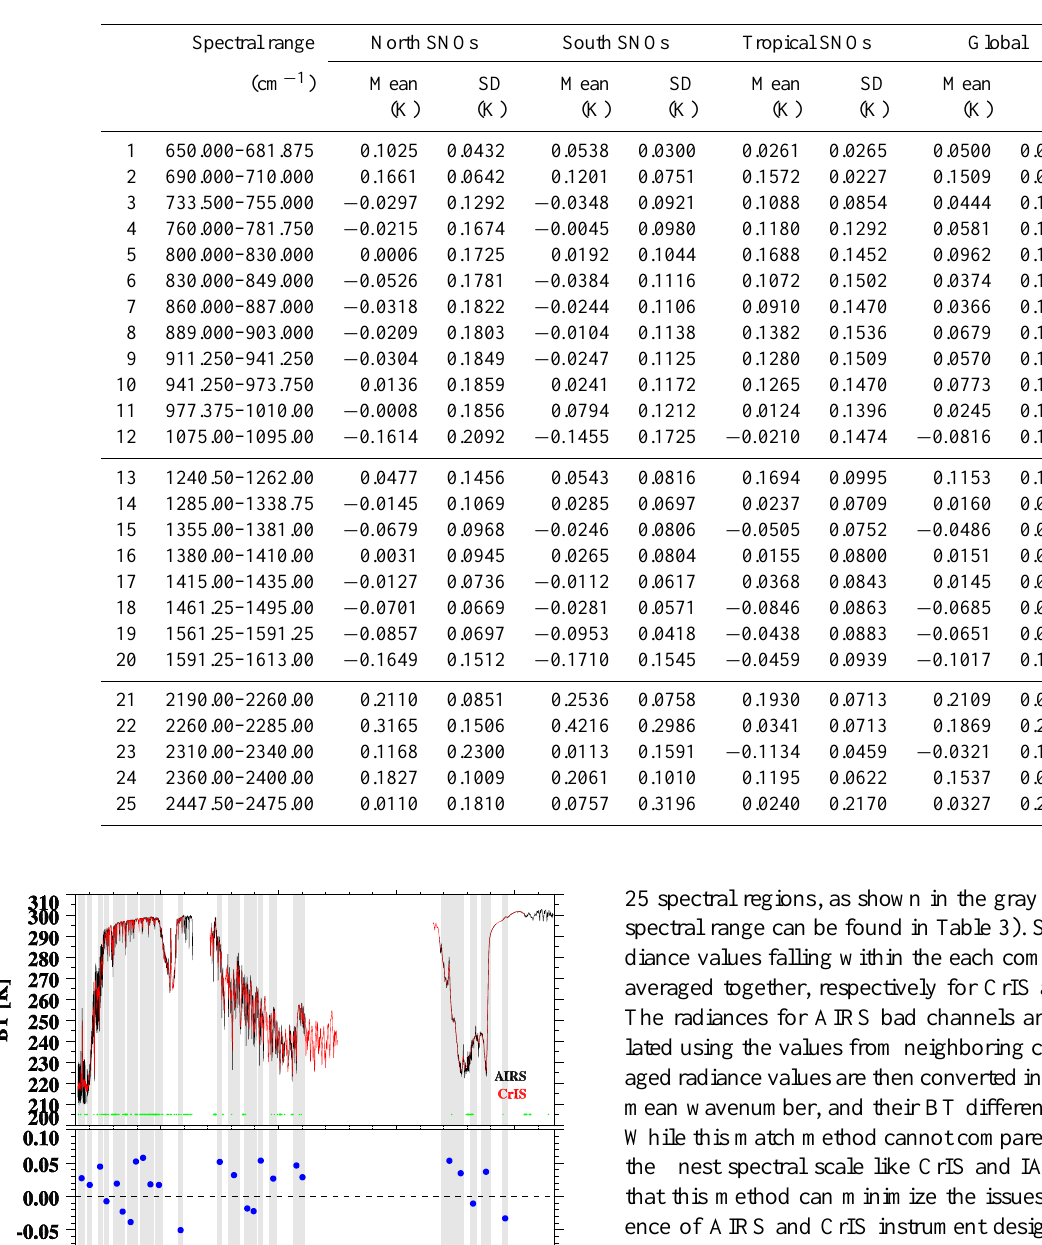
Table 3. Statistics of CrIS–AIRS BT differences at 25 spectral regions.